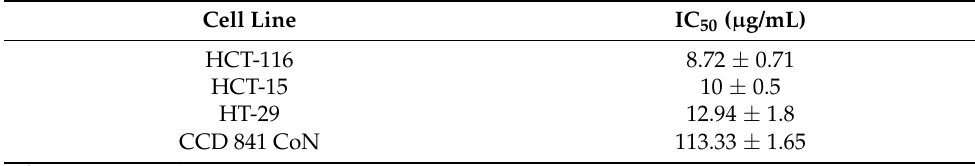
Figure 2. HT-29, HCT-15, HCT-116, and CCD 841 CoN cells were seeded in 96-well plates and treated with varying concentrations of PPE (1–100 µ g/mL) and 5FU (0.03–1.5 mM) for 24 h. Its cytotoxic activity was evaluated by MTT ( A ) Effect of PPE on the viability of HT-29, HCT-15, HCT- 116, and CCD 841 CoN; ( B ) Effect of 5FU on the viability of HCT-116 and CCD 841 CoN. The values indicate ± SD ( n = 3); * p < 0.05, ** p < 0.01, and *** p < 0.001 vs. control. Table 2. IC 50 values of PPE in CRC cells and CCD 841